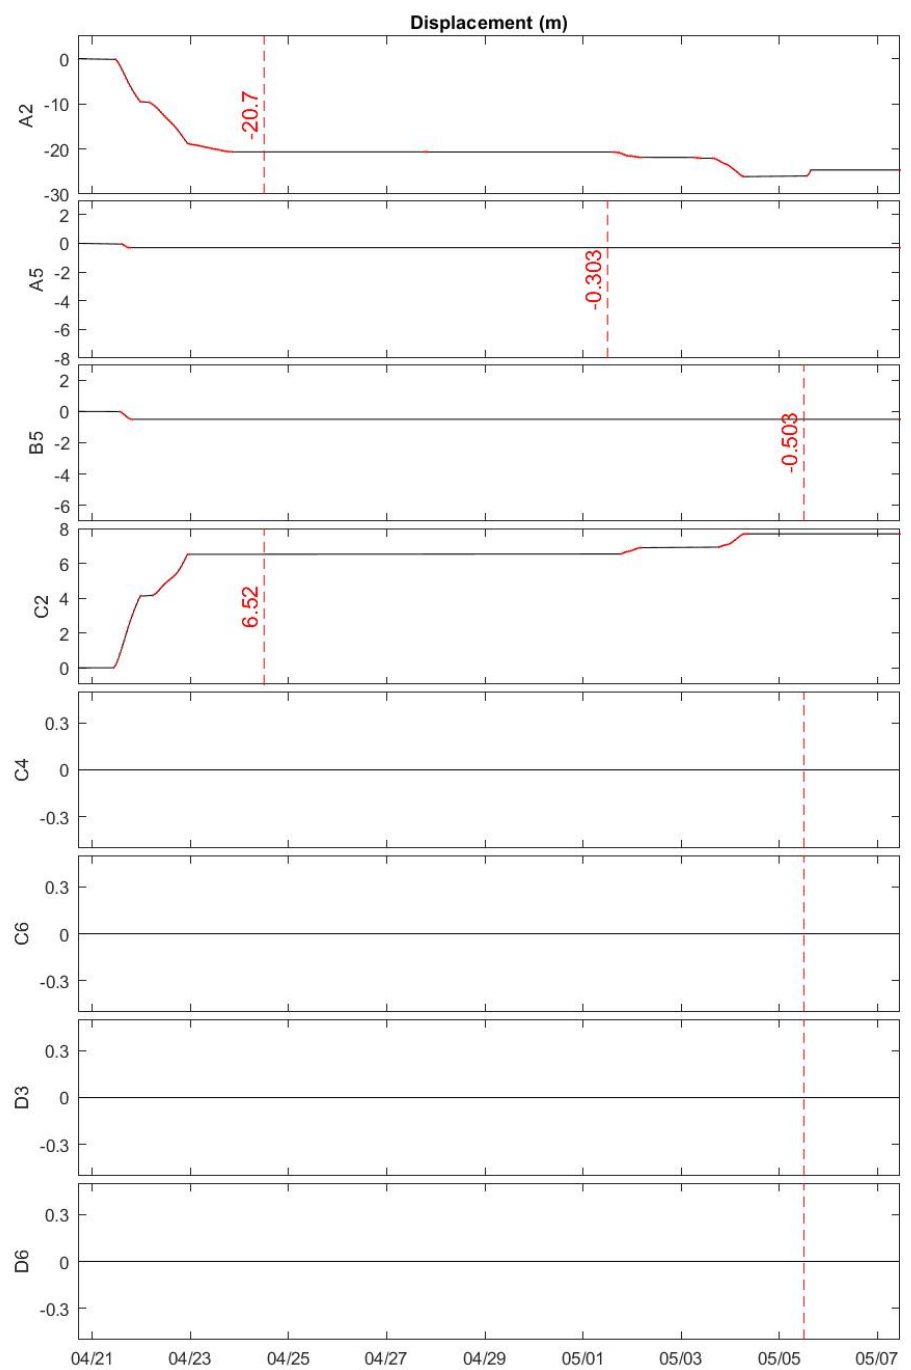
Figure 12. Model predicted displacement l ( t ) for each object at the shallow quadpod from 20 April to 7 May 2013. Among the eight objects, only A2 and C2 were immediately mobile and displaced 20.7 m (A2) and 6.52 m (C2) on 12:00 24 April 2013 (dashed line). Other munitions A5, B5, C4, C6, D3, D6 were completely motionless. According to the TREX13 report [13], the objects A2 and C2 were immediately mobile and transported out of the field of view because they were last seen on 23 April 2013. After 23 April 2013, their locations have never been